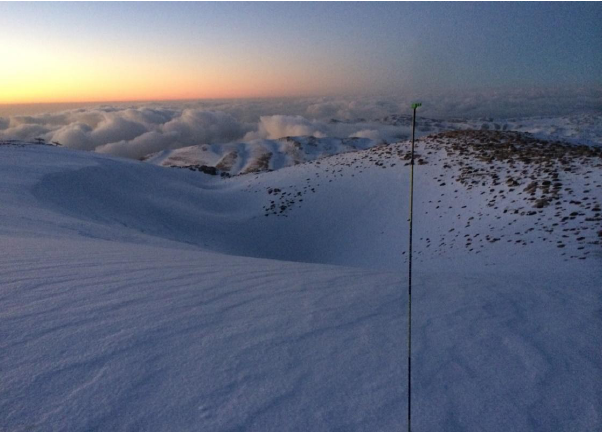
Figure 12. Snow redistribution following a major snowfall event at 2310ma.s.l., 200m away from the MZA AWS (located to the left of the image). Image taken on 15 January 2016. Snow depth at the station was 7.5cm. Snow depth measured with snow probes in the vicinity ranged between 0 and 258cm ( n = 46) with an average of 117cm (median = 99cm) and a standard deviation of